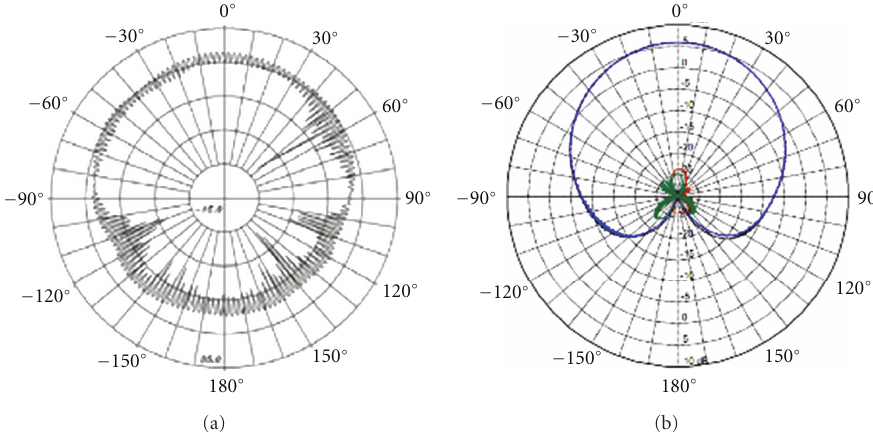
Figure 4: Utilized antenna gain pattern: (a) Ublox and (b)